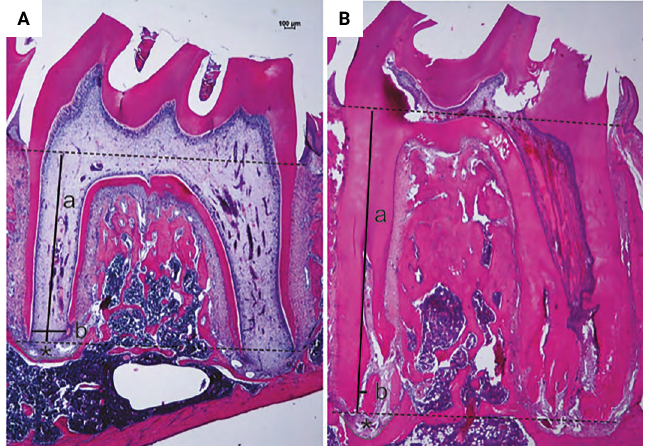
Figure 2. Microphotographs showing HE stained histological sections of the mandibular first molar corresponding to the initial (A; i.e. 25-day-old) and final (B; i.e. 80-day-old) control groups. Dashed lines served as landmarks passing through the cement enamel junction and the apex of both roots. Lines a and b were drawn to measure the length of the distal root and the apical diameter of its root canal, respectively. The asterisk indicates the location of the periapical area. Note that, A presents a wide root canal as well as very thin walls and HERS can still be